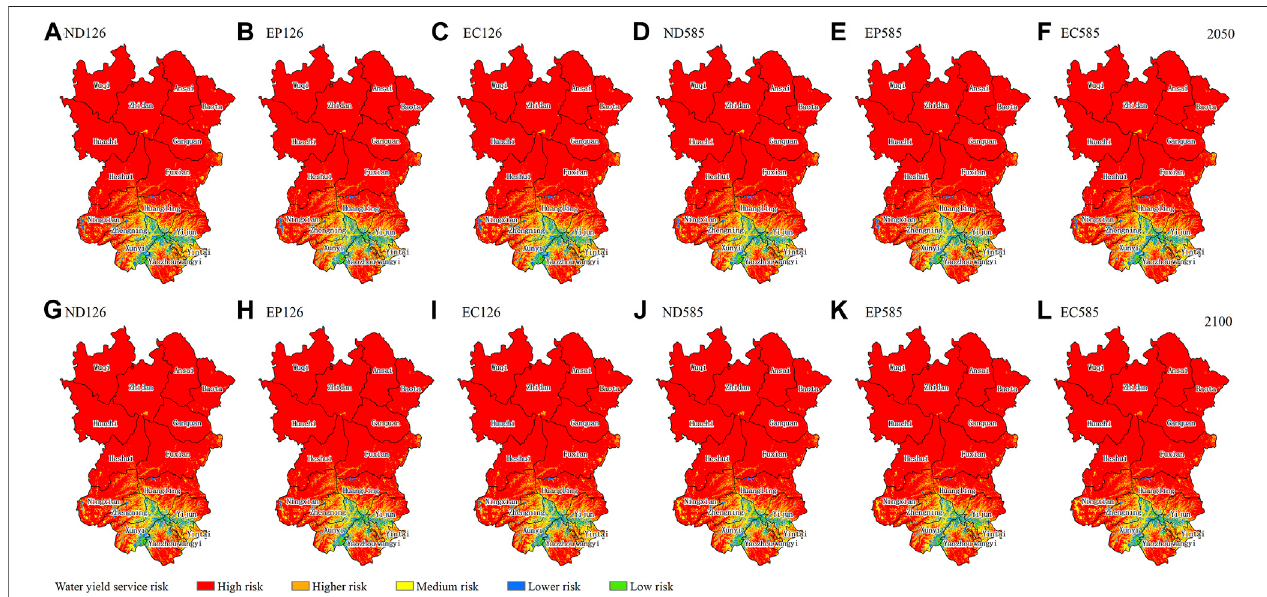
FIGURE 6 | Spatial variation in the water yield service risk in the ZMR under different scenarios in 2050 (A – F) and 2100 (G – L) . Note: ND-the natural development scenario of land use, EP-the ecological protection scenario of land use, EC-the economic construction scenario of land use, 126-climate paths SSP1-2.6, 585-climate paths